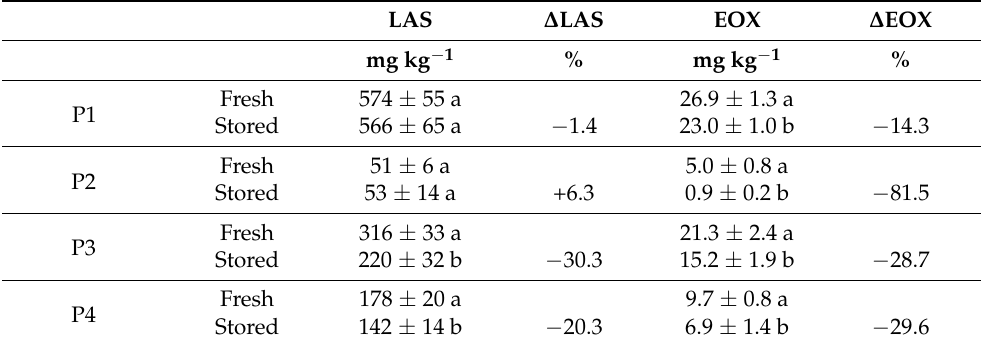
Table 5. Linear alkylbenzene sulfonates (LAS) and extractable organic halogens (EOX) concentrations in fresh and stored sewage sludge samples. Different letters (a, b) refer to significant differences (HSD test, P < 0.05). All data are expressed on a dry weight